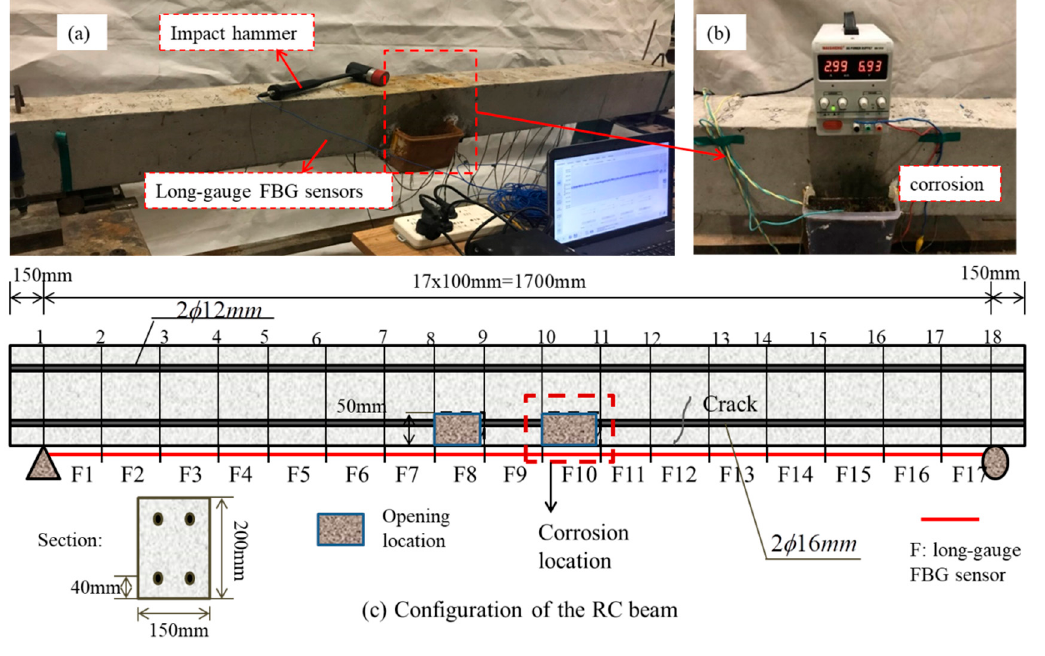
Figure 7. Illustration for the reinforced concrete (RC) beam; ( a ) The tested RC beam; ( b ) Corrosion setup; ( c ) Configuration of the RC